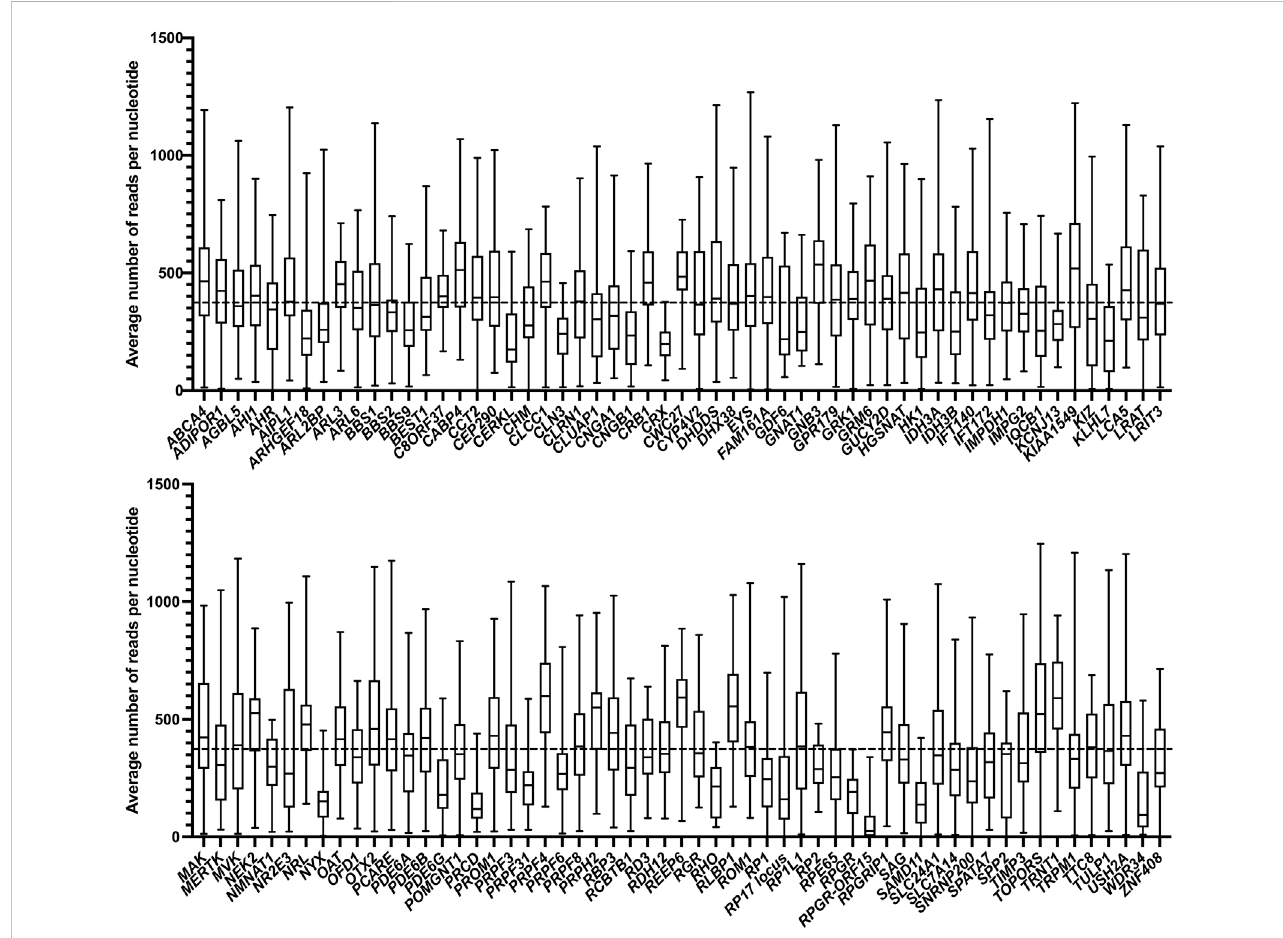
FIGURE 2 Average coverage per nucleotide. The average number of reads per nucleotide for each individual gene are indicated by the black horizontal line within the box, the range is indicated by the whiskers. The horizontal dashed line depicts the average overall coverage (374x).